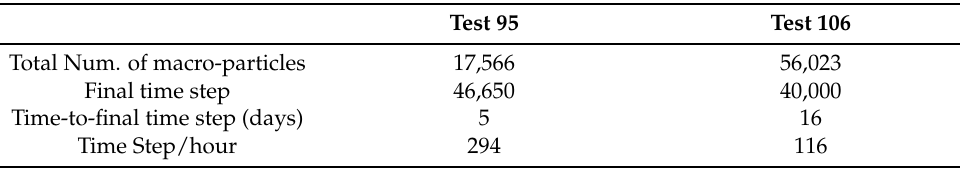
Table 5. SPT-100 discharge simulation: computational